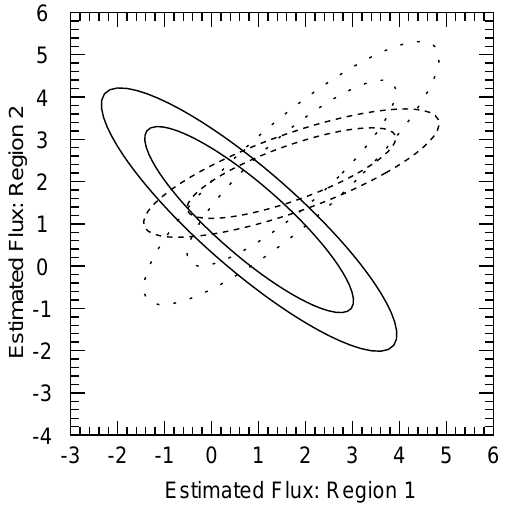
Fig. 4. Schematic of relations between top-down and bottom-up estimates for idealised case of two flux components which differ greatly in the quality of bottom-up